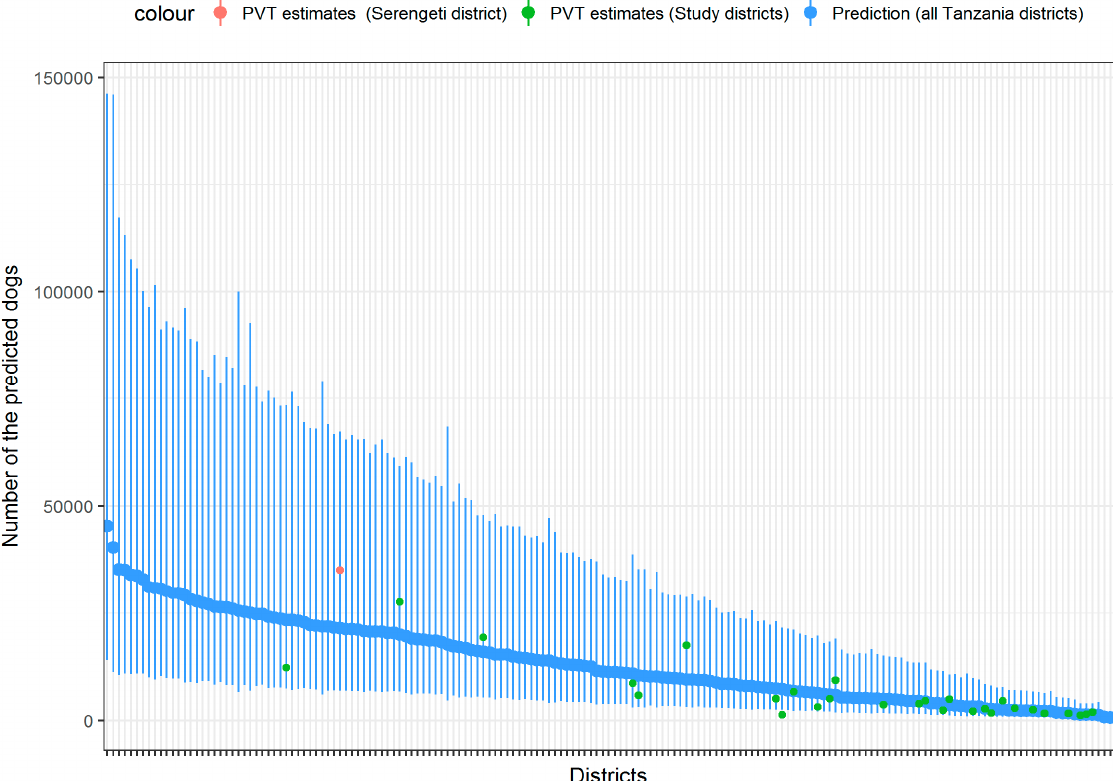
Figure 3. The predicted number of dogs in districts across Tanzania. The predictions and prediction intervals are shown in blue and compared to the dog population estimated directly from transects for a non-study district (Serengeti, in red) and for the study districts. Most of the green points (27 out of 28) from the model-building set were within the prediction intervals, suggesting that the fit of the model is reasonably good, with no outlier districts for whom the model is making poor predictions. Districts are ordered according to those with the largest (left-hand side) to the smallest predicted dog population (right-hand side). District names are shown in Figure A2. Serengeti transects were conducted in August 2015. PVT = post-vaccination transects.